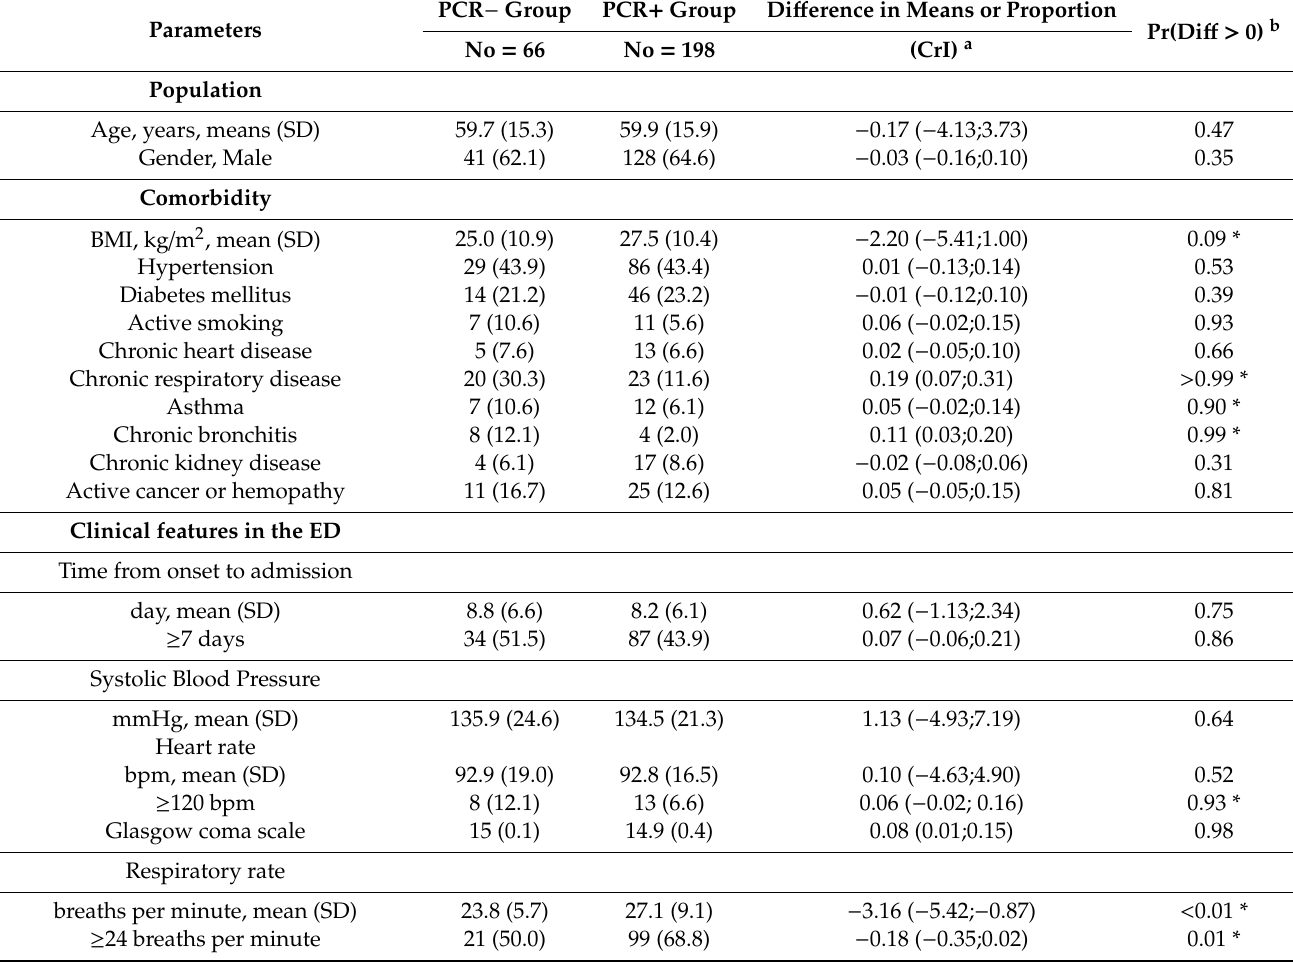
Table 1. Clinical